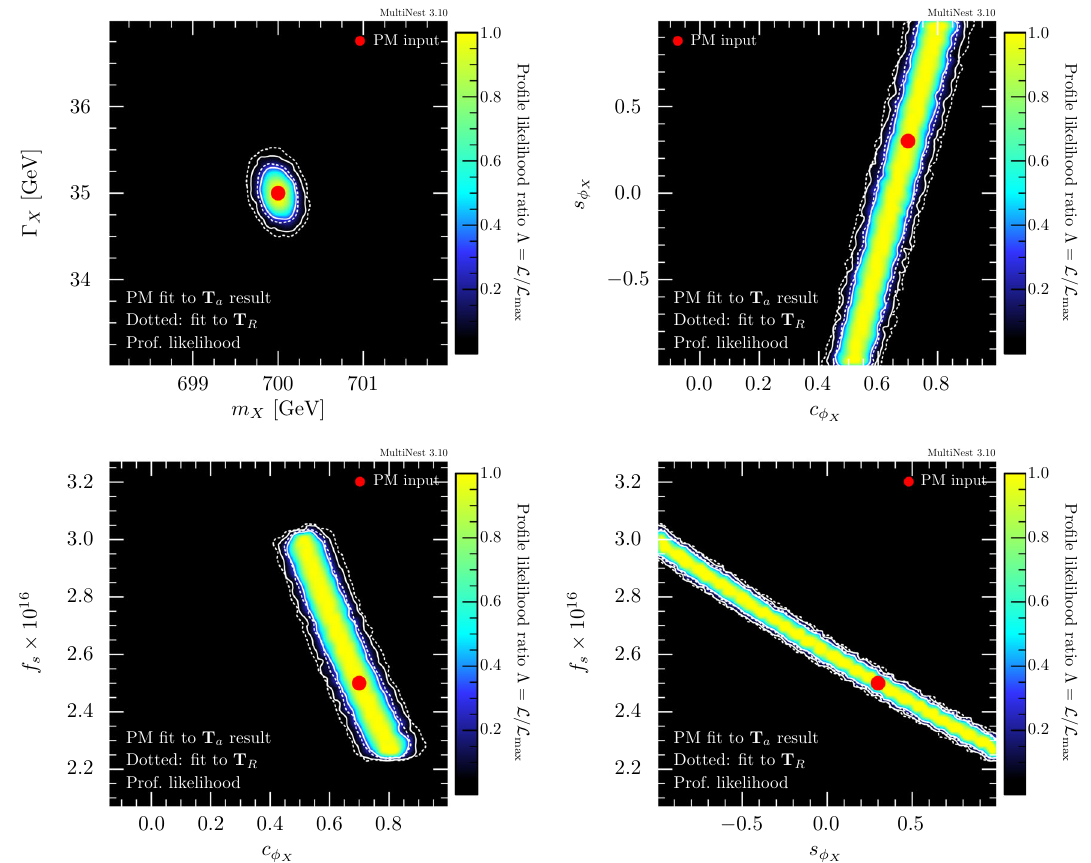
700 ± 40GeV mass window. 1 σ and 2 σ contours are outlined in solid white ( T a ) and dotted white ( T R ). Input PM points are marked with a red